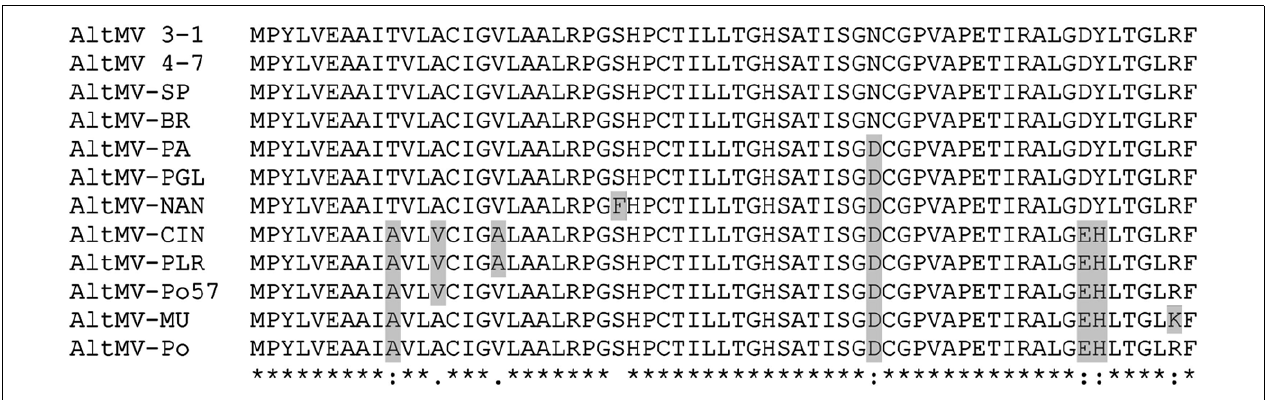
FIGURE 6 |Alignment ofTGB3 amino acid sequences of differentAltMV isolates. Residues that differ from the consensus of phlox-derived isolates are highlighted; AltMV isolates CIN, PLR, Po57, MU, and Po are “portulaca-type” isolates that are also differentiated from “phlox-type” isolates by differences in the CP amino acid sequence (J. Hammond and M.